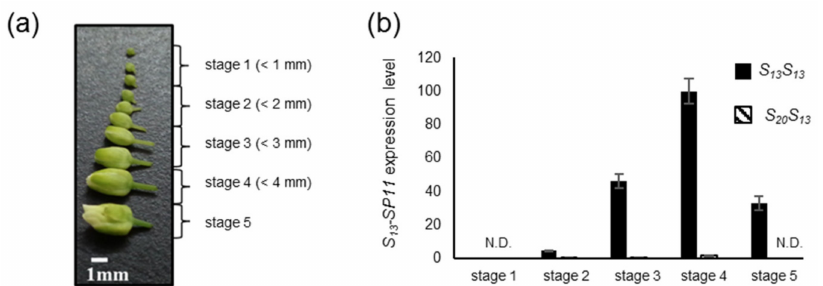
Figure 1. S 13 -SP11 expression in anthers during each stage of development and dominance– recessivity relationship between the S 20 and S 13 haplotypes. ( a ) Developmental stages of Arabidopsis lyrata anthers: stage 1, <1 mm; stage 2, <2 mm; stage 3, <3 mm; stage 4, <4 mm; stage 5, the day before flowering. ( b ) RT-qPCR analysis of S 13 -SP11 expression in S 13 S 13 homozygotes and S 13 S 20 heterozygotes. Elf1 α was used as an endogenous reference gene. The results shown are means ± s.d. of 3 replicates. N.D., not